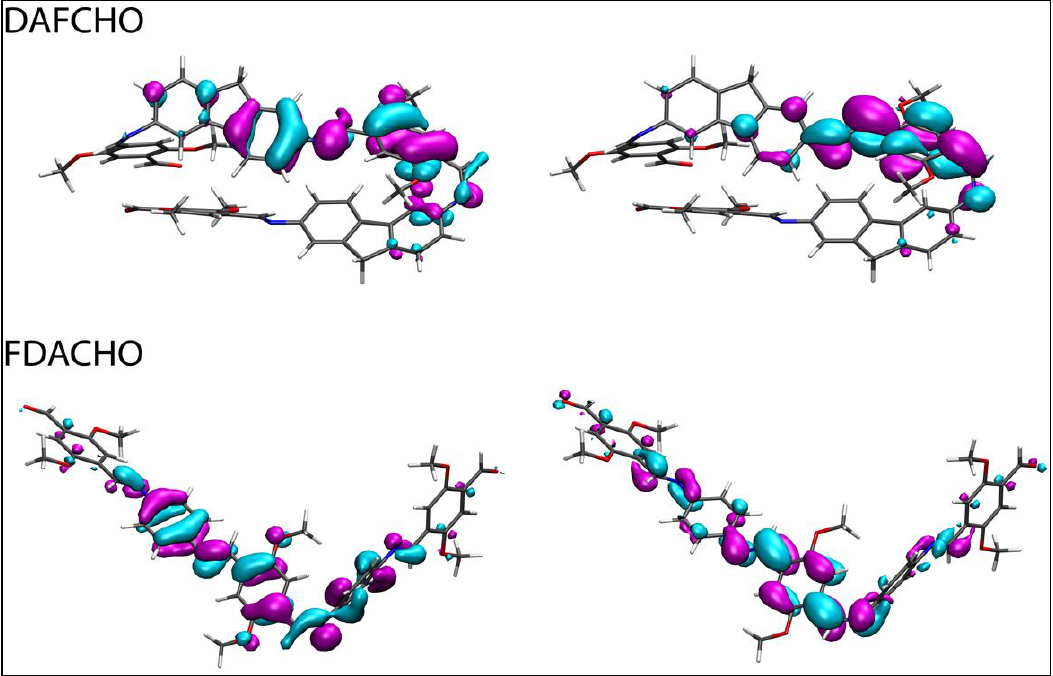
Figure 8. Isosurfaces of the frontier NTOs representing the hole (left) and particle (right) spatial location for the second electronic transition of DAFCHO and the first electronic transition of FDACHO.